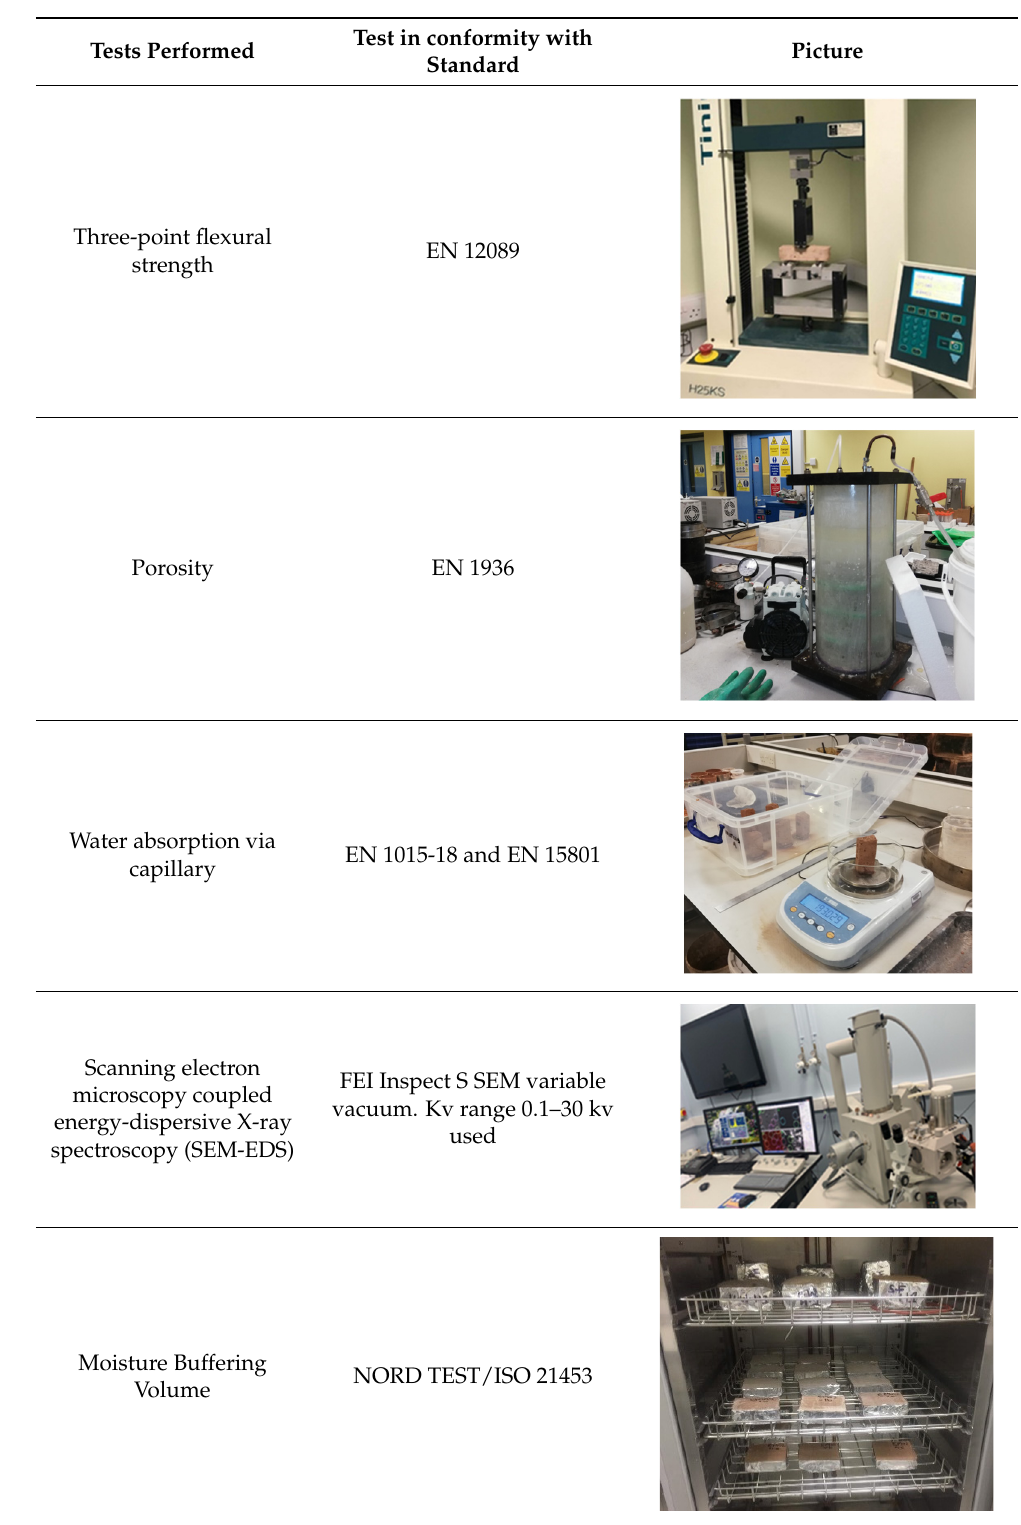
Figure 3. The different types of transport processes in an earth or cement-based medium based on Ref. [33]. In order to understand the influence the biostabilisers have in the micro and macro properties of the cement- and earth-based mortars, this chapter focuses on the discussion of the results regarding the microstructure modifications detected through SEM/EDS, water absorption via capillary, moisture buffering, mechanical strength, and porosity. 3.1. Bulk Density The following figure (Figure 4) presents the bulk density for the cement- and earth- based mortars (plain) with and without biostabiliser